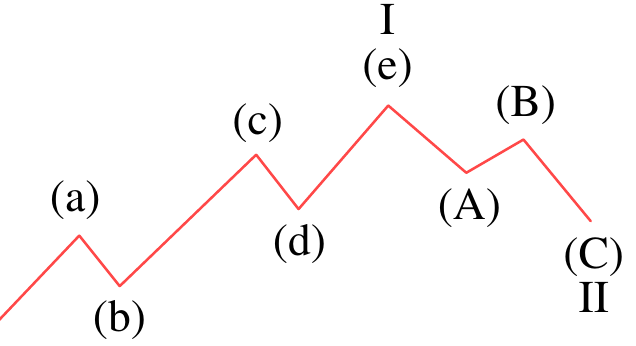
Figure 2. The basic model of the Elliott